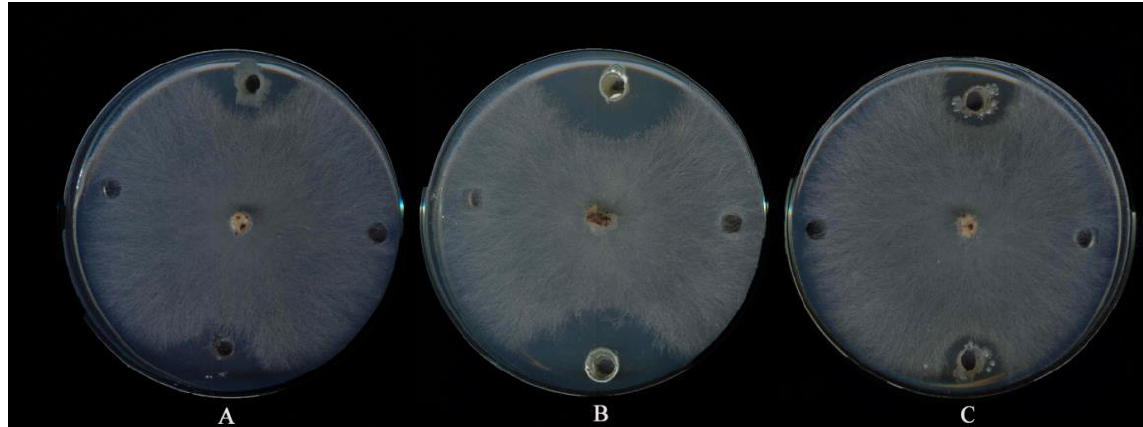
Figure 4. Inhibitory impacts of aqueous culture filtrate of antagonist isolates in the well diffusion method against Rhizoctonia solani . Control (left and right: CG medium), ( A ) culture filtrate (top and bottom) of isolate No. 5 at 11th day, ( B ) isolate G at 6th day, and ( C ) isolate U at 8th day post seeding time.